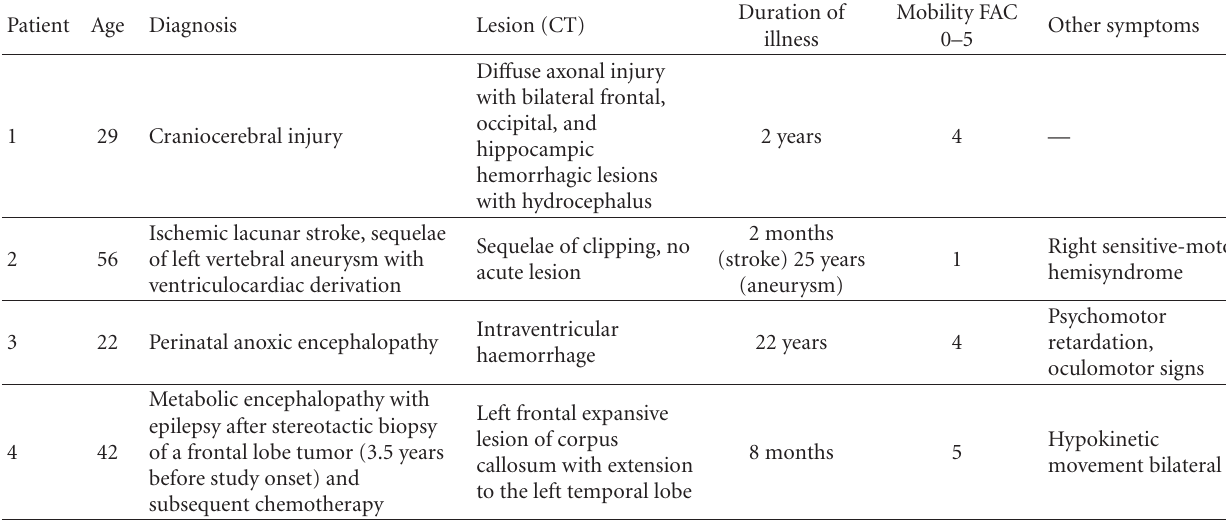
Table 1: Patient characteristics; CT: computed tomography; FAC: functional ambulatory category [13].